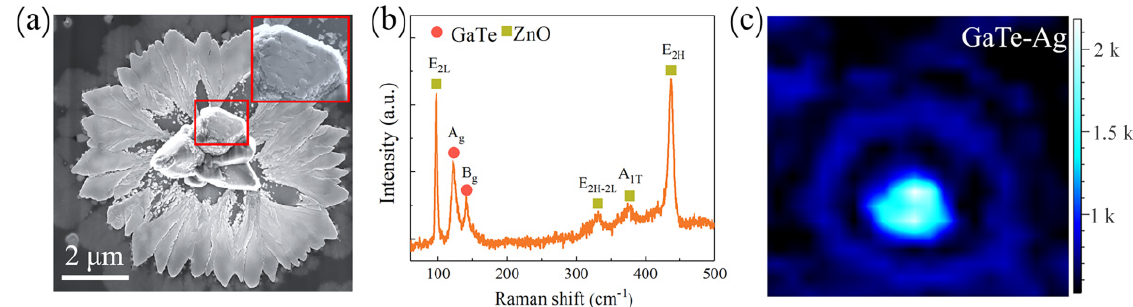
Figure 4. Optical properties of the GaTe nanosheet flower. ( a ) SEM image of a flower-like GaTe nanosheet. The inset magnifies the region marked by a pink rectangle, which shows clearly that both the surface and the side of the ZnO nanorod are densely packed with GaTe nanosheets. ( b ) Raman spectrum for the GaTe nanosheet flower. ( c ) Raman mapping and the corresponding SEM image is shown in ( a ). The size of the area adopted for Raman mapping is 15 × 15 μ m.